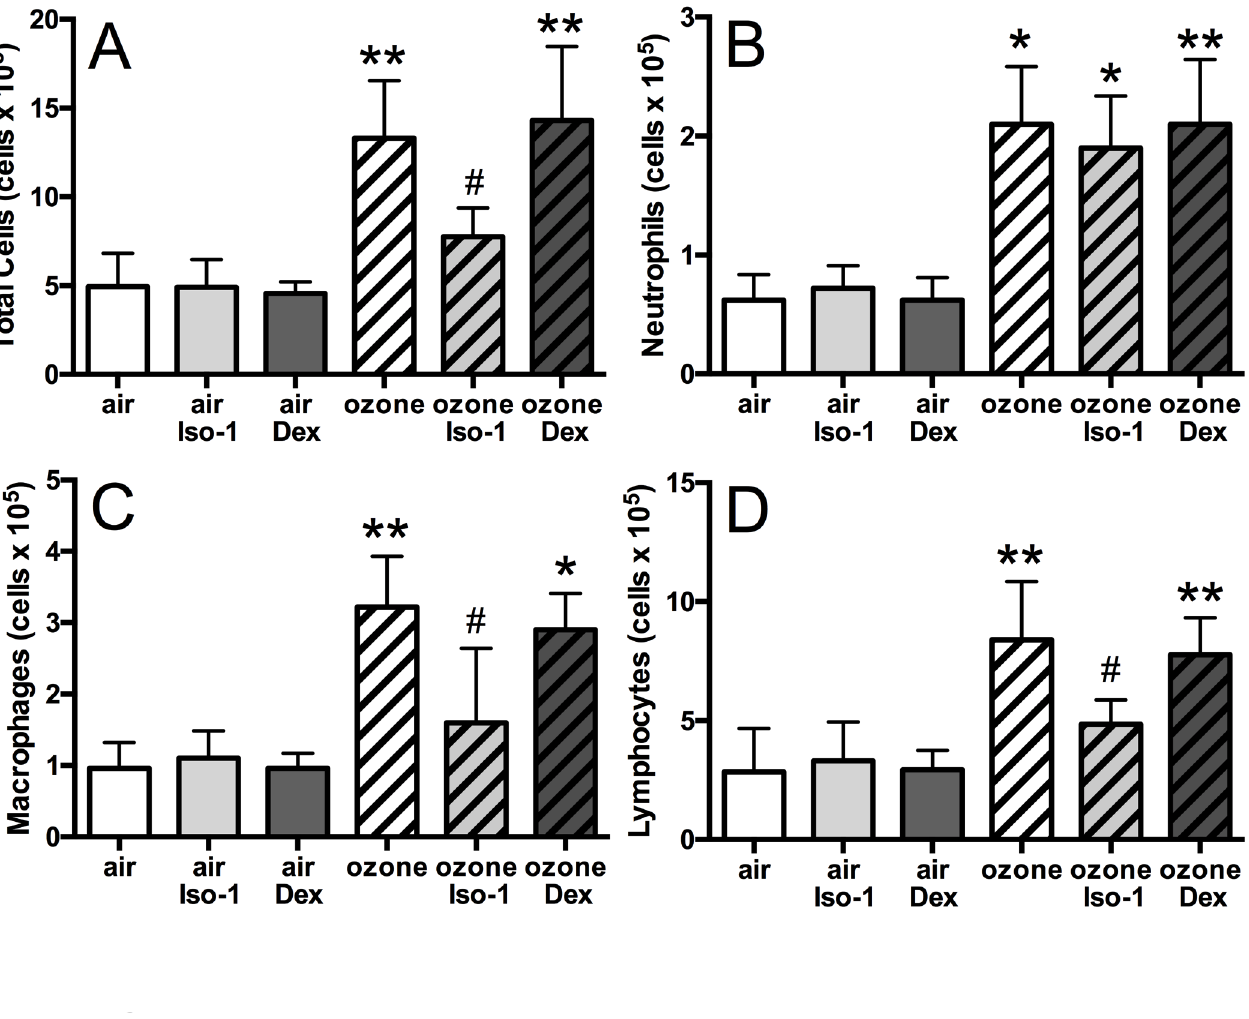
Fig 3. Effect of ISO-1 and dexamethasone on ozone-induced airway inflammatory cells. Total cell count (A), neutrophil (B), macrophage (C), and lymphocyte (D) counts in mouse BAL samples. Data are expressed as mean ± SD for 6 animals per group. * p < 0.05 and ** p < 0.01 compared to air controls, # p < 0.05 compared to ozone exposed